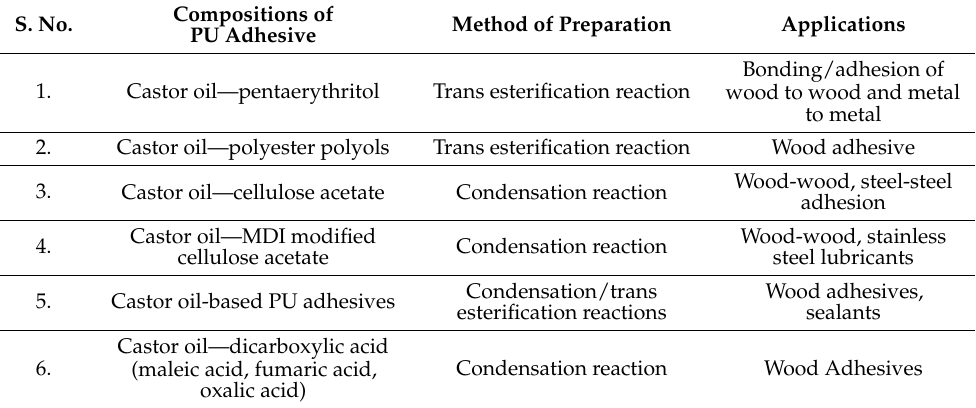
Table 4. Different Compositions of PU Adhesives Derived from Castor Oil